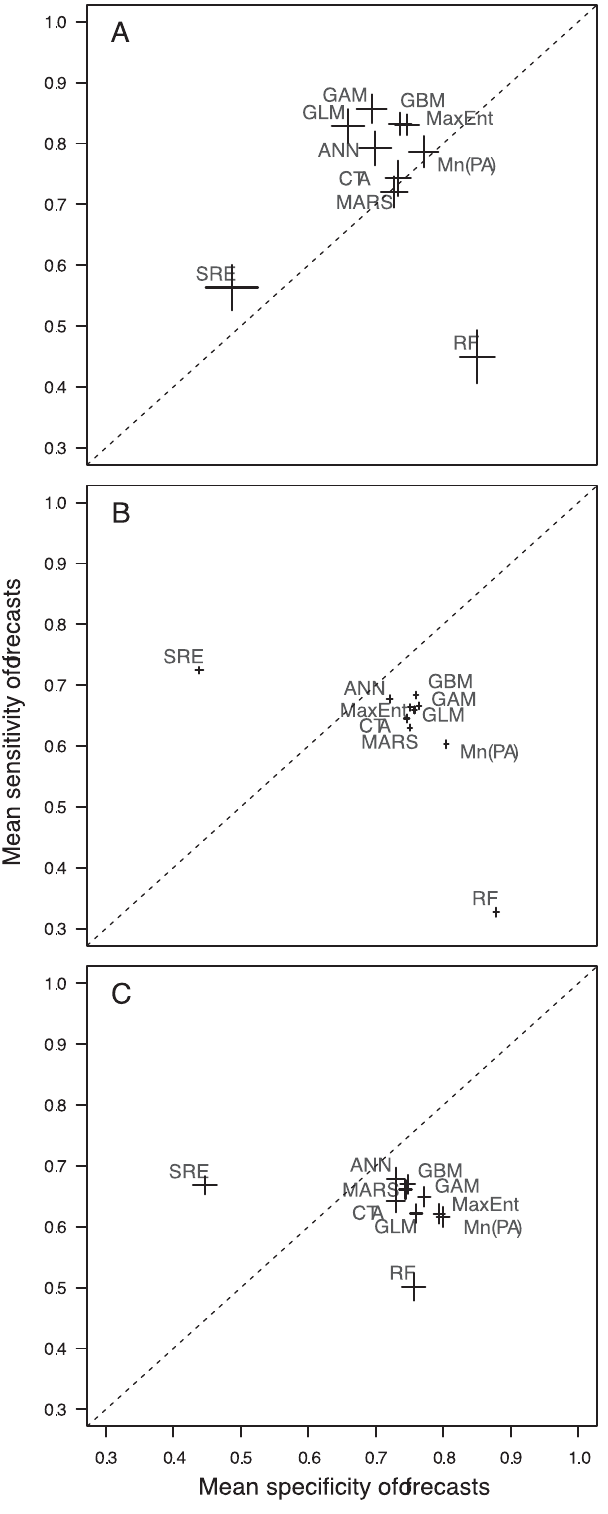
Figure 2. Mean sensitivity versus mean specificity of model forecasts. Mean sensitivity and specificity of forecasts generated by each modelling framework for (A) butterflies, (B) plants, (C) birds. Error bars represent 6 1 standard error of the mean. The dotted line indicates the condition where mean sensitivity = mean specificity.